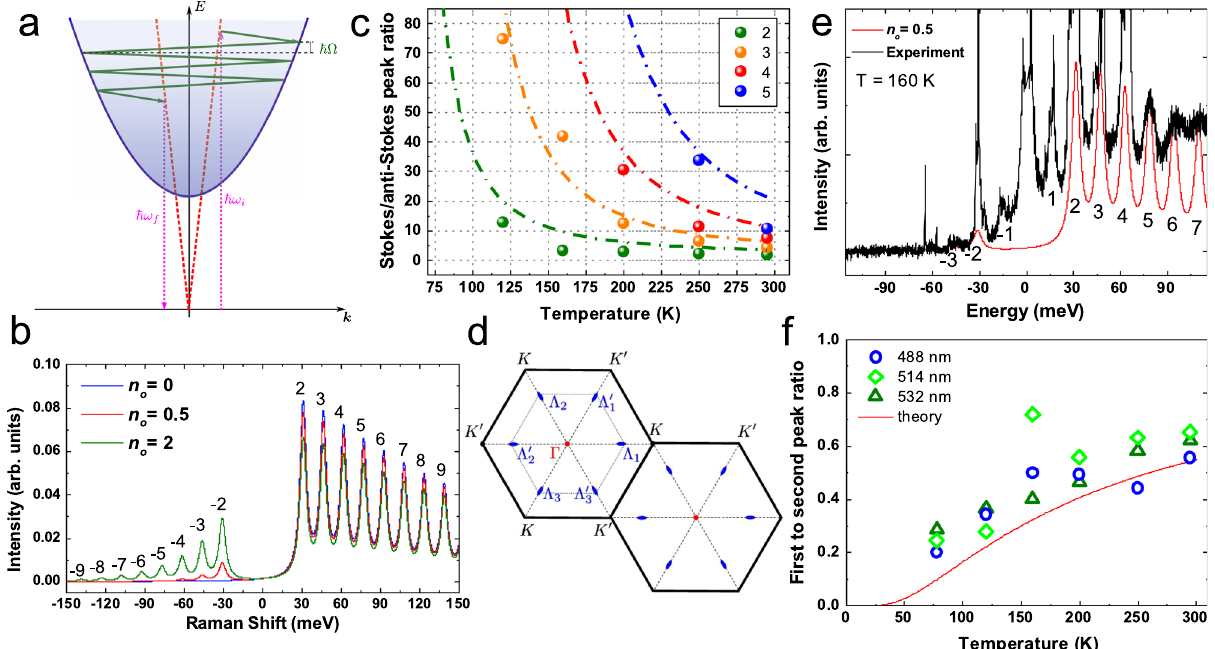
Fig. 3 Comparison between experiments and theory. a Scheme of phonon-assisted hot PL. The incident, _ ω i , and outgoing, _ ω f , photons are shown by dotted magenta vertical arrows. The phonons participating in the cascade are indicated by the green arrows. The e – h pair dispersion curve is the blue parabola. The light cone is shown by red dashed lines. b Calculated S/AS spectra at different T. c I S /I AS for different numbers of cascade steps as a function of T. Filled circles are experimental data at 532 nm. The fi t with Eq. (9) is indicated by dot-dashed lines. d Extended BZ of 1L-WSe 2 . Corresponding valleys are marked as Γ , K , K 0 and Λ i , Λ 0 i ( i = 1, … , 3). e Experimental data at 160K (black line) compared to the calculated spectrum from Eq. (2) for n o = 0.5. f Ratio of measured intensities of j = 1 to j = 2 peaks and corresponding fi t with Eq.